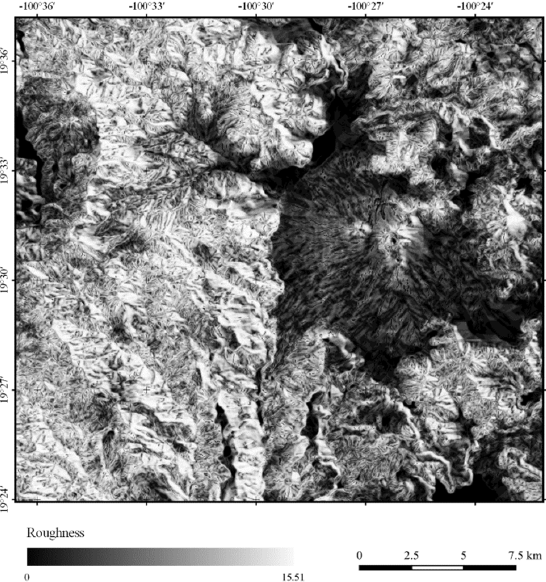
Figure 12 . Stretched image of the global treatment applied to a DEM with a 20 m resolution and a 5 × 5 moving window.